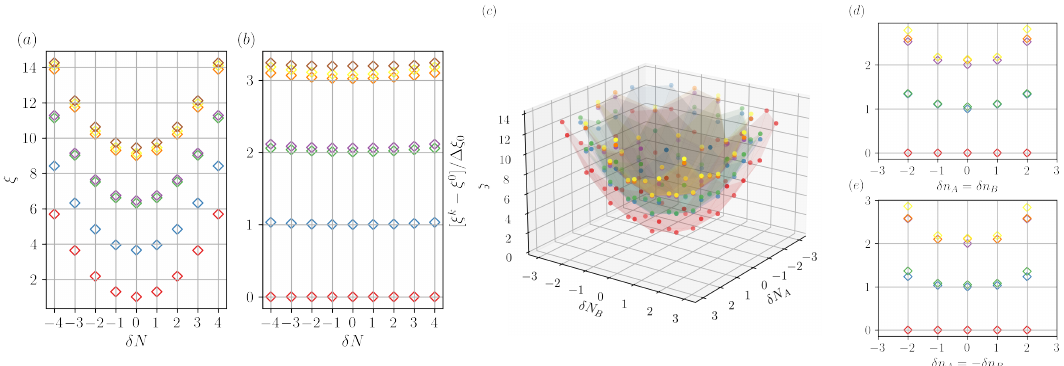
Figure 2: Entanglement spectrum for the L = 256 BH chain with open boundary con- ditions at U / J = 1 ( ( a ) and ( b ) ) and for the L = 96 BH2S chain with periodic bound- / U = − 0.1 ( ( c ) , ( d ) and ( e ) ). In ( a ) the parabolic envelopes’ ary conditions at U AB structure is the marker of the emergent CFT. For the BH2S model the parabolas be- / δ N come parabolic surfaces on the δ N plane (in ( c ) ). Panel ( b ) shows the same A B data of ( a ) obtained by subtraction of the lowest parabola ξ k = 0 and by setting the distance between ξ k = 1 and ξ k = 0 equal to one in order to better appreciate the δ N = 0 δ N = 0 equally spaced structure and the degeneracies. In ( d ) and ( e ) the equivalent proce- dure as in ( b ) is applied to the diagonal sections of the paraboloids which correspond = δ N = − δ N to the density ( δ N ) and the spin channel ( δ N ) respectively. After A B A B the phase transition to PSF, only the eigenvalues of the density channel ( d ) maintain the conformal behaviour while the spin channel acquires a gap as shown below in